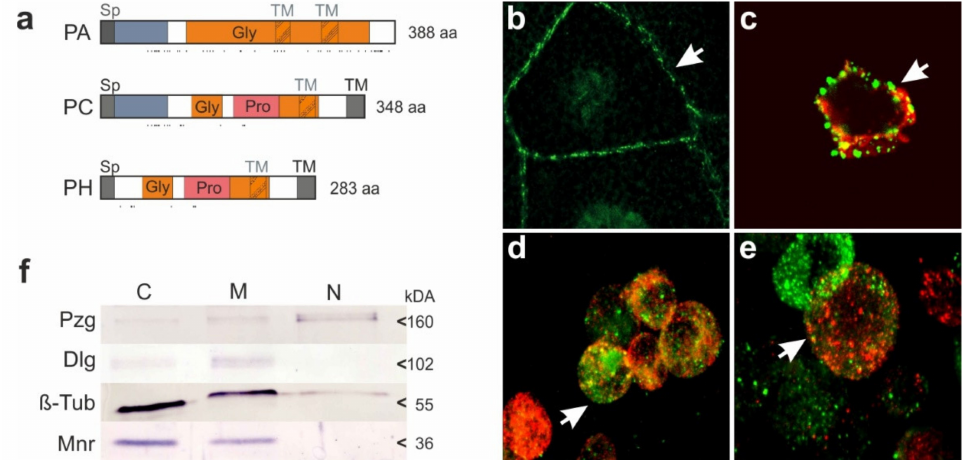
Figure 5. CG32521 encodes membrane-bound proteins Mnr. ( a ) Sketch of presumptive proteins PA, PC and PH encoded by CG32521. Size is to scale, amino acids (aa) are given. All proteins contain a signal peptide (Sp), and Glycine rich domains (Gly). Moreover, PA and PC share the N-terminal 88 amino acids (blue). In addition, PC and PH are enriched in Proline residues (Pro). Predicted transmembrane domains (TM) are shaded in grey. Potential O-glycosylation sites are marked below by dashes. PA has a predicted molecular weight of 36.5 kDa; PC of 35.06 kDA and PH of 28.5 kDa. ( b – e ) Antibodies directed against Mnr (green) outline the plasma membrane of salivary gland cells (arrow) ( b ). In Schneider S2 cells, membranes are stained as well within dotted structures that co-localize with Phalloidin ( c ), and with the Golgi markers Hook ( d ) and GM130 ( e ). ( f ) Cytoplasmic C, membrane M, and nuclear N fractions of S2 cells reveal accumulation of Mnr in the cytosol and membrane. As reference, the nuclear protein Pzg, the transmembrane protein Dlg and beta-tubulin were detected. Approximate protein size is given in